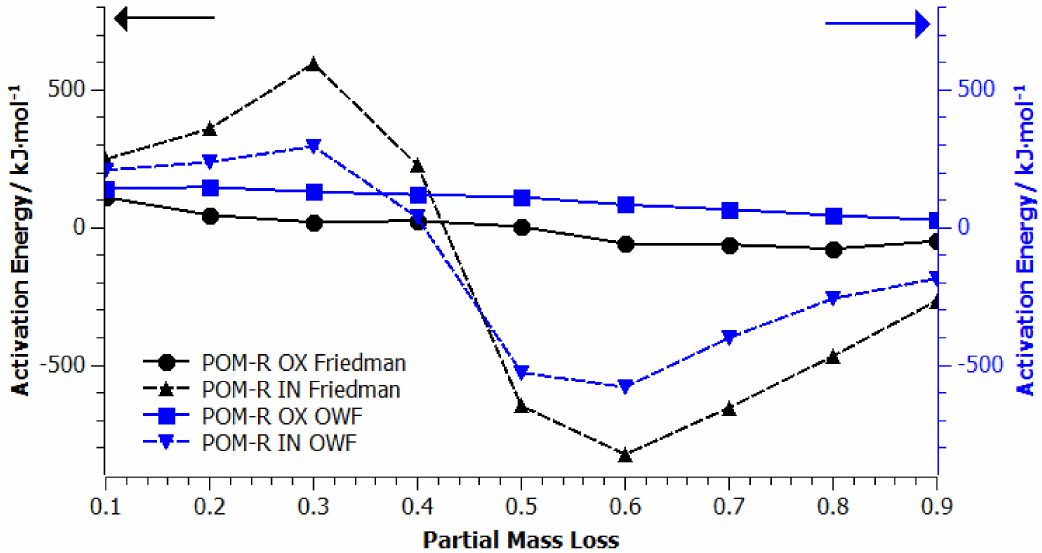
Figure 7. Apparent activation energy vs. partial mass loss found from the slope of isoconversion lines from Friedman (black lines) and OWF (blue lines) analyses of POM-R plots, where OX stands for tests carried out in an oxidizing atmosphere and IN in an inert